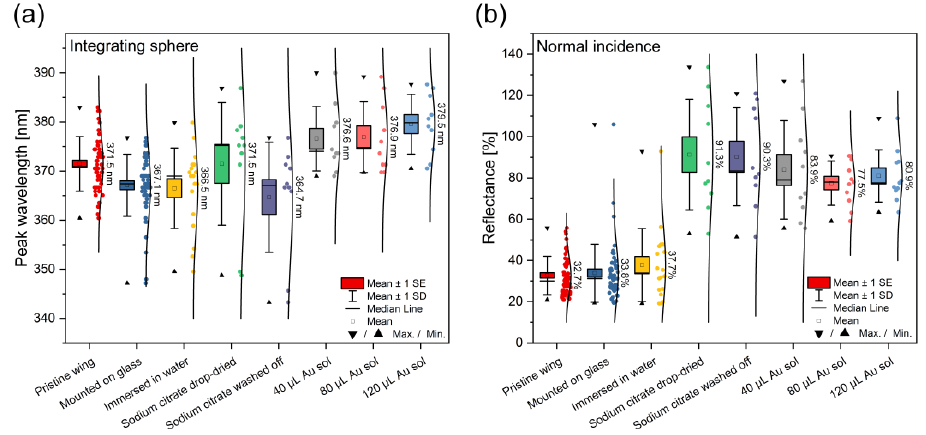
Figure 6. Statistical presentation of the changes in optical properties of male Polyommatus icarus wings mounted on glass substrate by PLA. ( a ) Integrating sphere measurement of the spectral position of the blue reflectance maximum after the different treatments of the wings; ( b ) normal incidence measurement of the amplitude of the blue reflectance maximum after the different treatments of the wings.